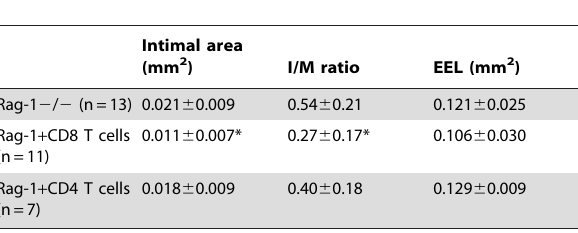
Table 2. Neointimal thickening 21 days after arterial injury.